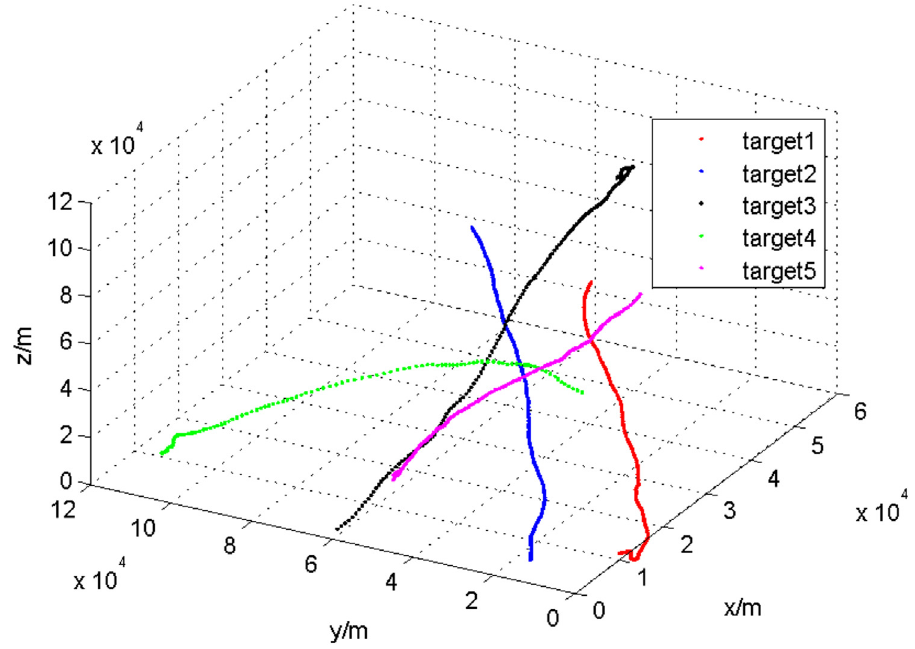
Fig 1. The target tracks with 5 targets.